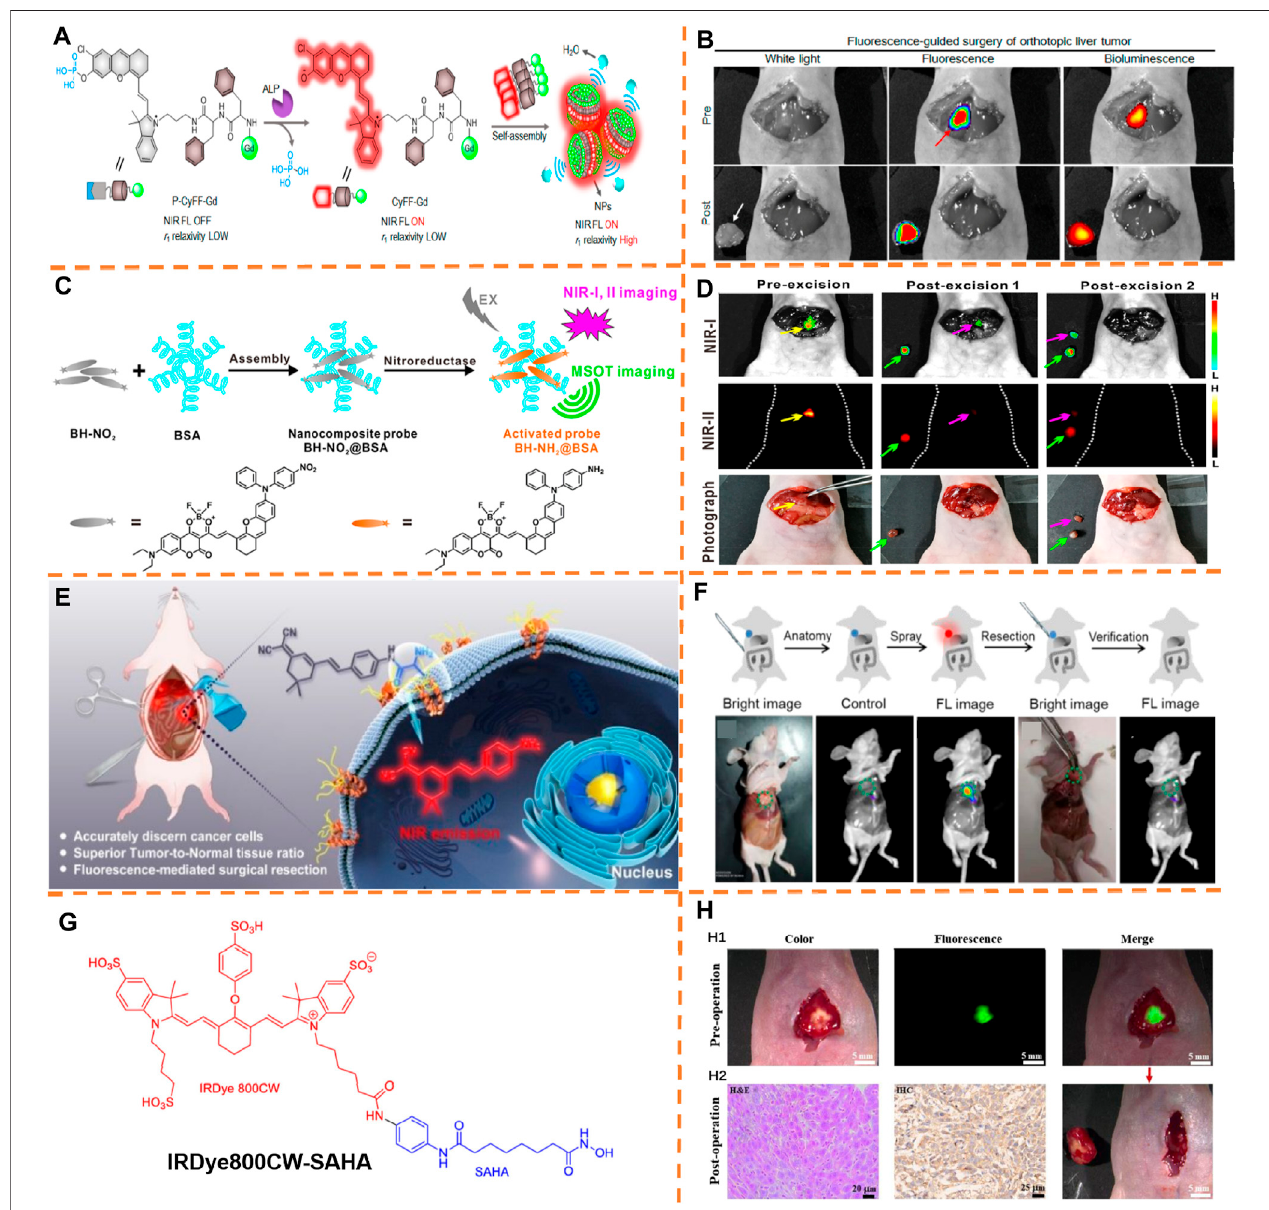
FIGURE 3 | (A) Chemical construction of P-CyFF-Gd and suggested alkaline phosphatase – adjusted fl uorogenic reaction and in situ self-gathering of P-CyFF-Gd into NPs. (B) Fluorescence-guided surgery of the orthotopic liver tumor. Adapted with consent from Yan et al. (2019). (C) Schematic explanation of production of the nanocomposite probe BH-NO 2 @BSA and its response to nitroreductase. (D) Image-guided tumor resection surgery using the nanocomposite probe. Adapted with consent from Zeng et al. (2020). (E) Schematic explanation indicating the course of activating YH-APN for APN among cancer cells. (F) In vivo imaging of mice bearing tumor and image-guided surgeries realized by the spray ofYH-APN. Adapted with consent from Li et al. (2020). (G) Chemical structure ofIRDye800CW-SAHA. (H) H1: Intraoperative NIR fl uorescence imaging of the liver tumor after injecting IRDye800CW-SAHA. H2: immunohistochemical staining for histone deacetylase 6 and H&E staining among tumor tissues (Tang et al.,